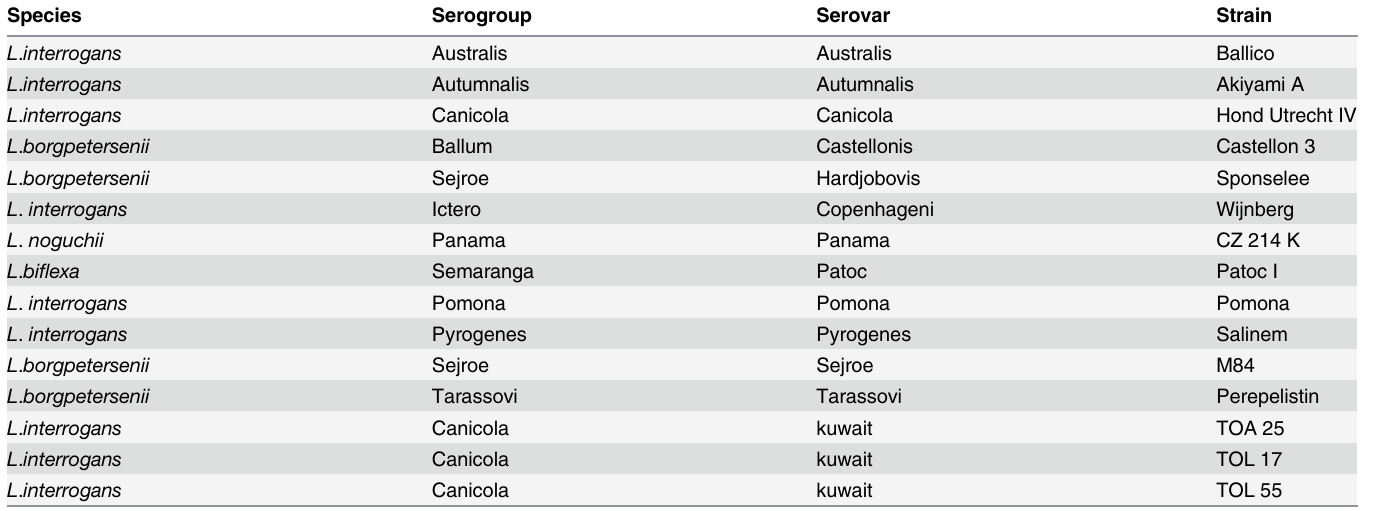
Table 2. Leptospira strains used in this